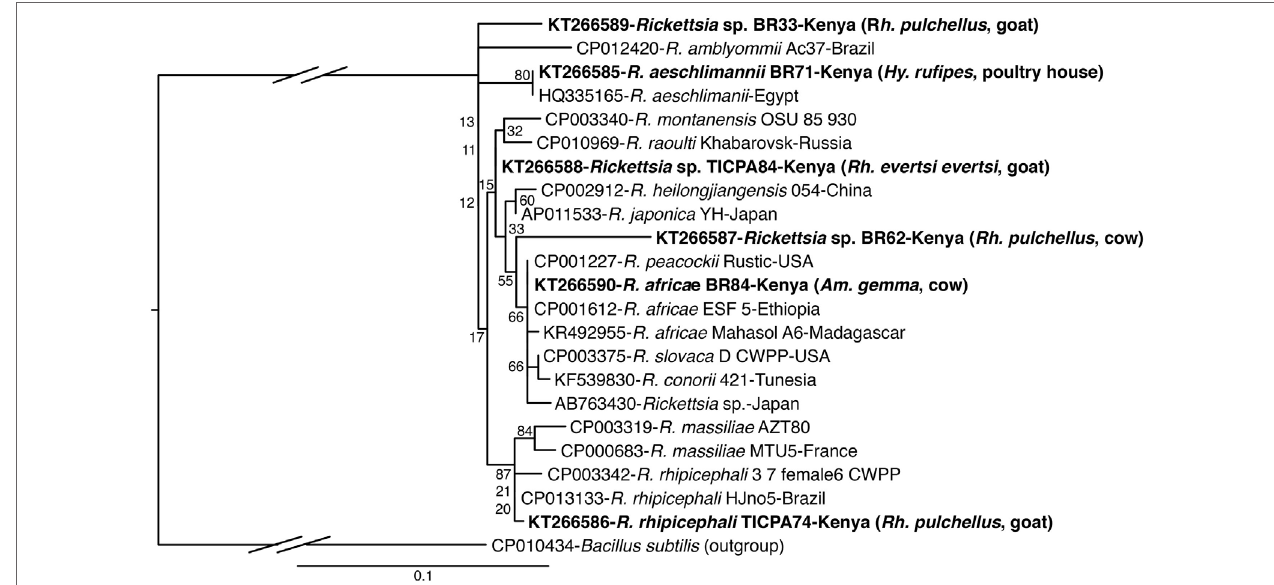
FigUre 4 | Maximum likelihood phylogenetic analysis of rpme/trna fMet gene fragments of Rickettsia sequences identified with related sequences . GenBank accession numbers, species identifications, isolates, and country of origin are indicated for each 16S rRNA gene sequence. Sequences from this study are in bold with tick and vertebrate host species associated with the study isolates indicated in brackets. Bootstrap values at the major nodes are of percentage agreement among 1,000 replicates. The branch length scale represents substitutions per site. The gaps indicated in the branches to the Bacillus subtilis outgroup represent 1.2 substitutions per site.